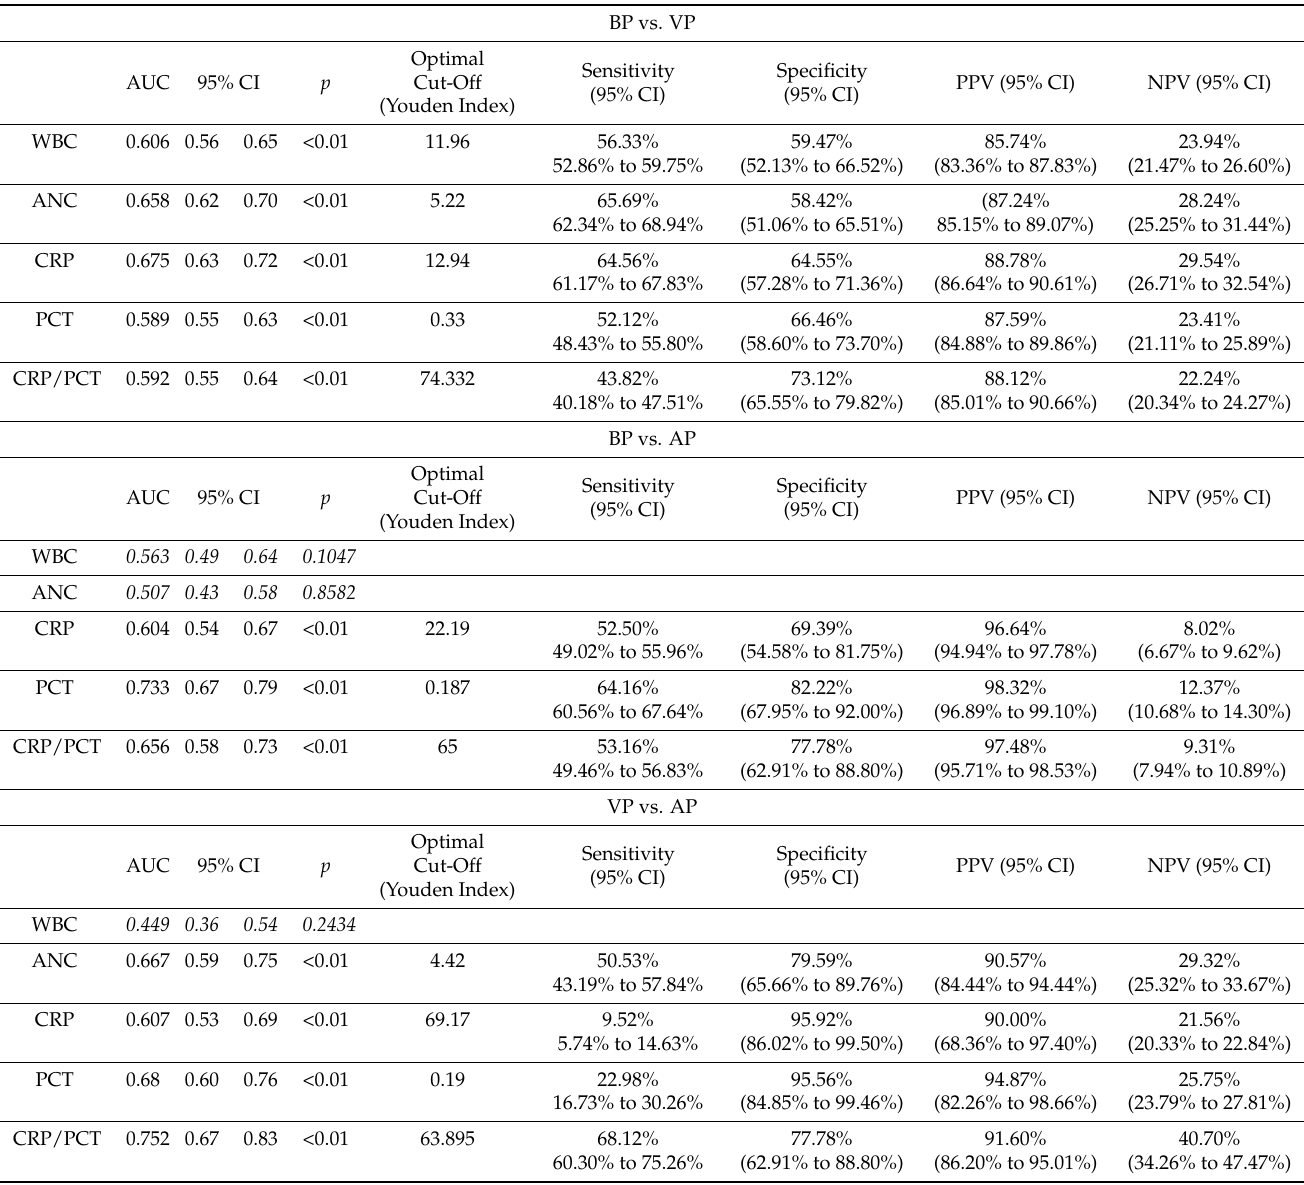
Table 3. Inflammatory markers in differentiation of pneumonia etiology—the results of the ROC-curve analysis. BP—bacterial pneumonia; VP—viral pneumonia; AP—atypical pneumonia; AUC—area under the curve; 95% CI—95% confidence interval; PPV—positive predictive value; NPV—negative predictive value. Inflammatory markers: WBCs—white blood cells; ANC—absolute neutrophil count; CRP—C- reactive protein; PCT—procalcitonin; CRP/PCT—CRP to procalcitonin ratio. Statistically non-significant values written in